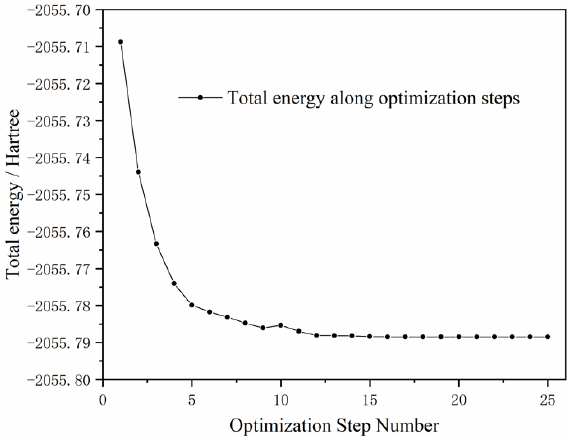
Figure 6. The total energy of coal along the optimization path.